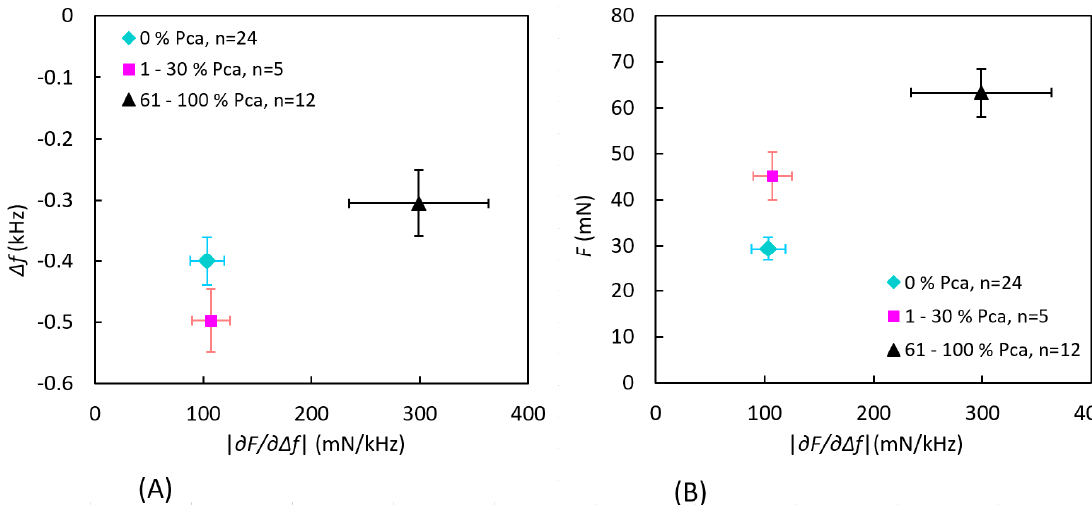
Figure 14. Measured values grouped by the amount of PCa occurrence within a semicircle with a radius of 3.5 mm at each measurement point for P-2. The data show the mean value of the stiffness parameter | ∂ F / ∂ ∆ f | ± standard error of the mean as a function of ( A ) the frequency shift ∆ f and ( B ) the contact force F . There were no findings in the interval 31–60% PCa.